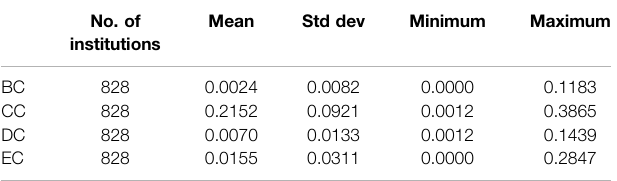
TABLE 4 | Descriptive statistics for network